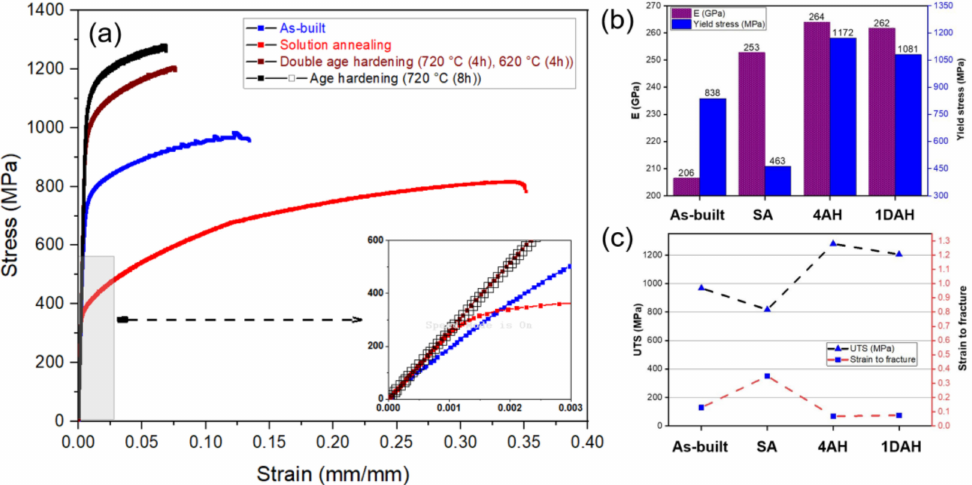
Figure 17. ( a ) Tensile stress-strain curves, ( b ) elastic modulus and yield stress, ( c ) ultimate tensile strength and strain to fracture Inc718 processed by micro-LPBF before and after heat treatment